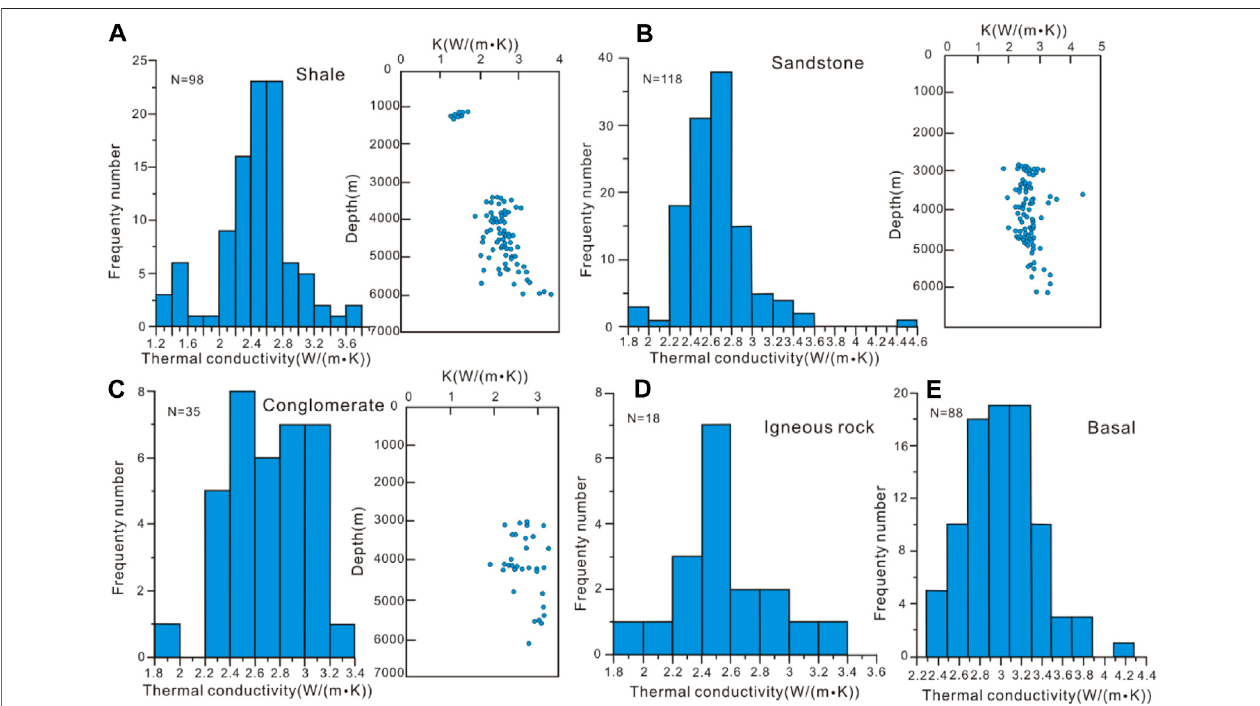
FIGURE3| HistogramofmeasuredthermalconductivityofdifferentlithologiesintheSongliaoBasin. (A) Shale; (B) sandstone; (C) conglomerate; (D) igneousrock; and (E) basement (modi fi ed following Shi Y. et al., 2019).